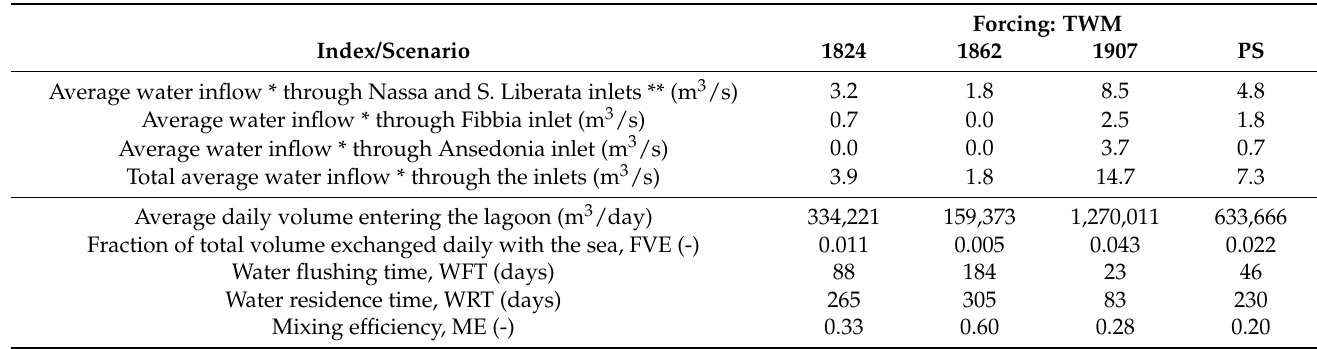
Table 4. Average water flux through the inlets and indexes of water transport timescale in the hindcast scenarios, under the forcing mechanisms of astronomical tide, wind, and meteorological tide